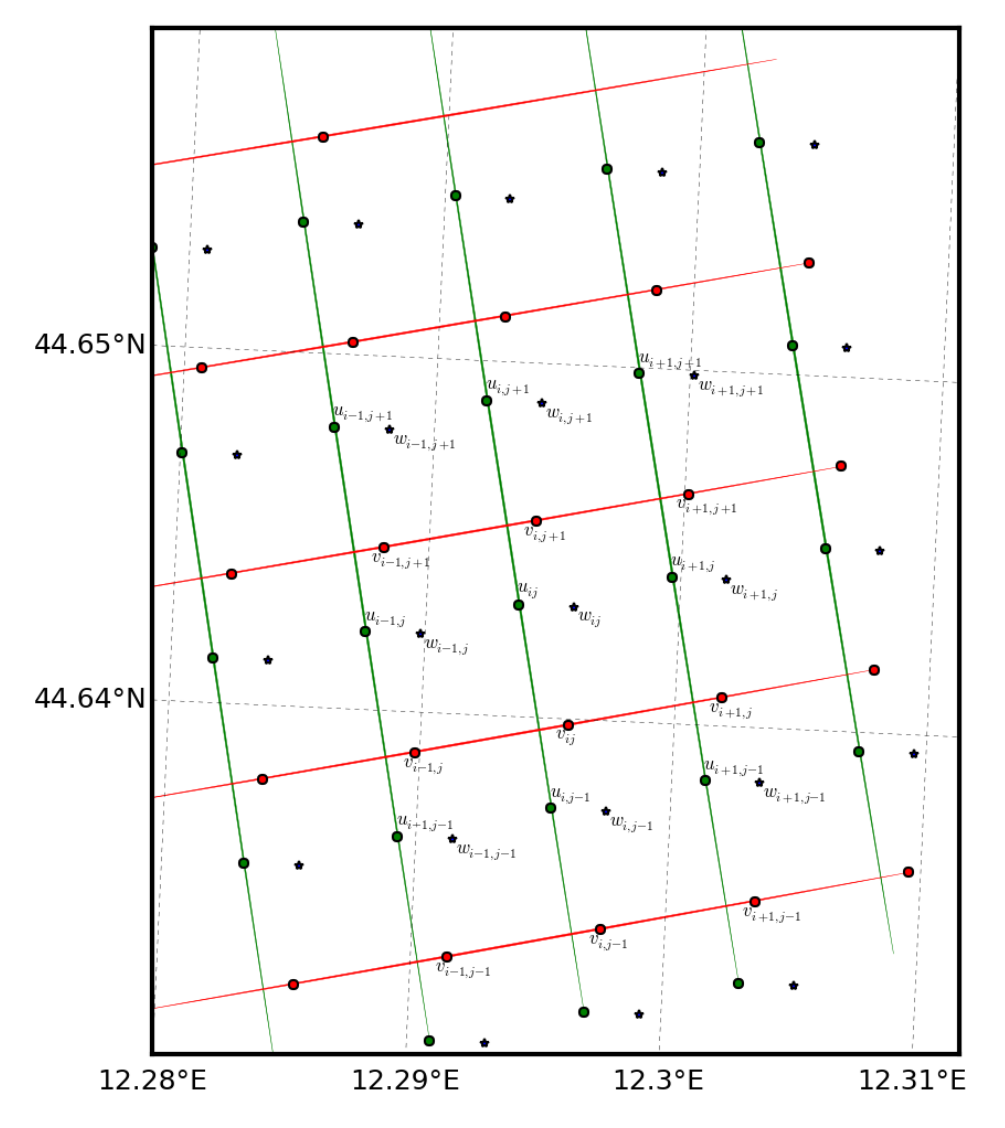
Figure 3. Grid detail: cell and edge